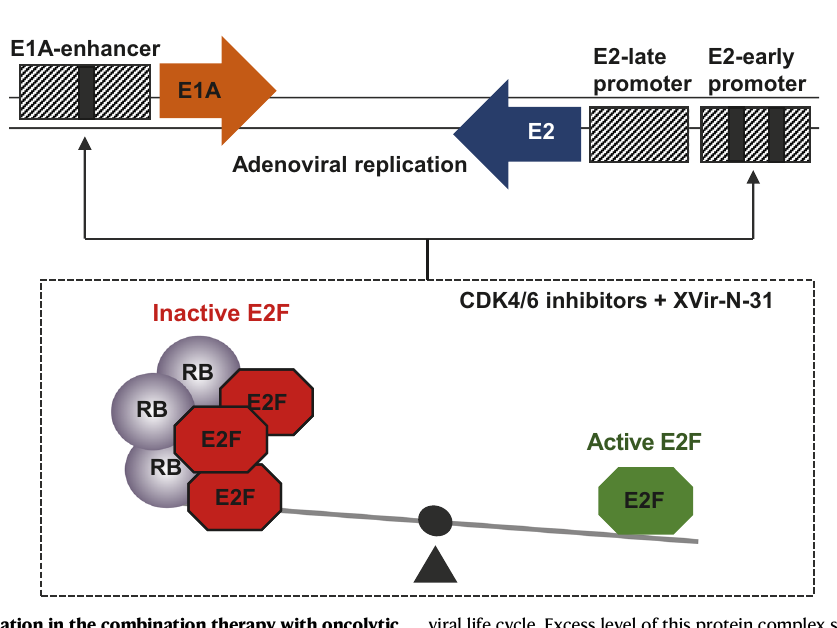
viral life cycle. Excess level of this protein complex suppresses ef fi cient transcrip- tion at early time points in the replication life cycle. Inhibition of RB and E2F1 protein level by CDK4/6-inhibitors might cause a shift towards low level of active E2F1 and thus facilitate early viral gene expression and replication.